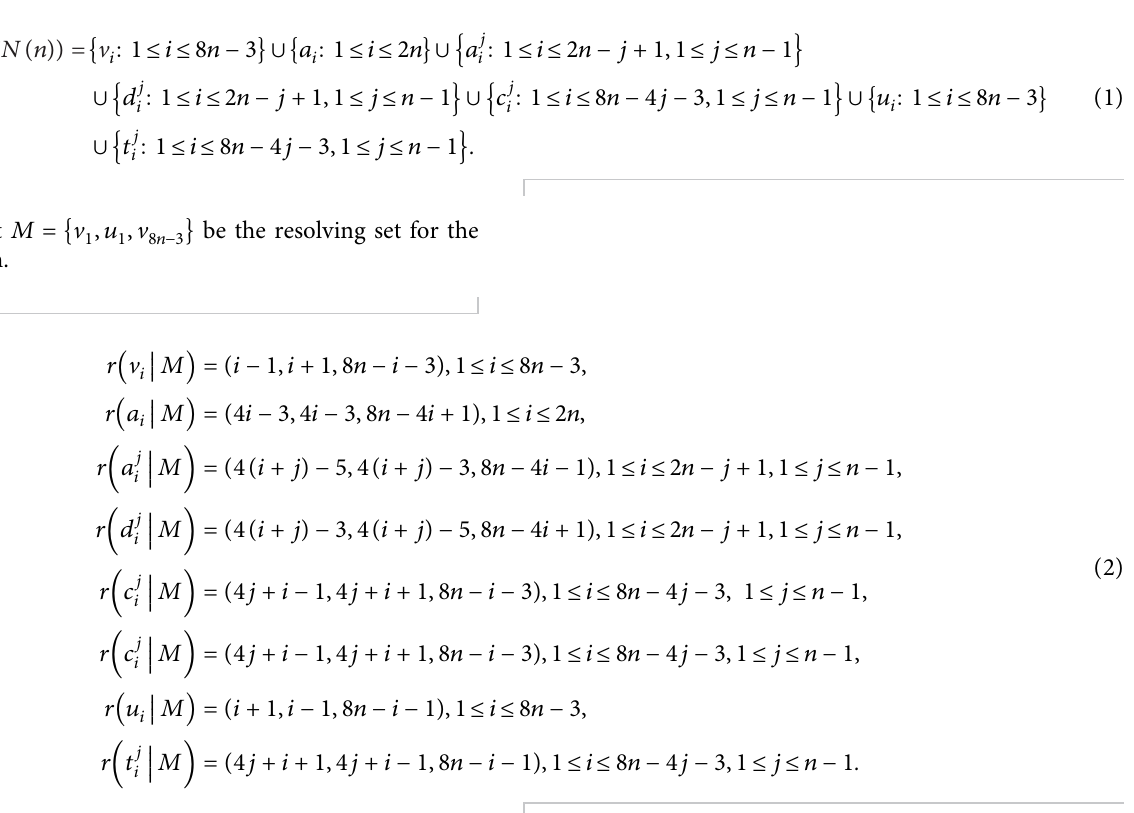
Figure 1: Honeycomb HCN ( 2 ) and subdivided honeycomb network SHCN ( 2 ) with 1